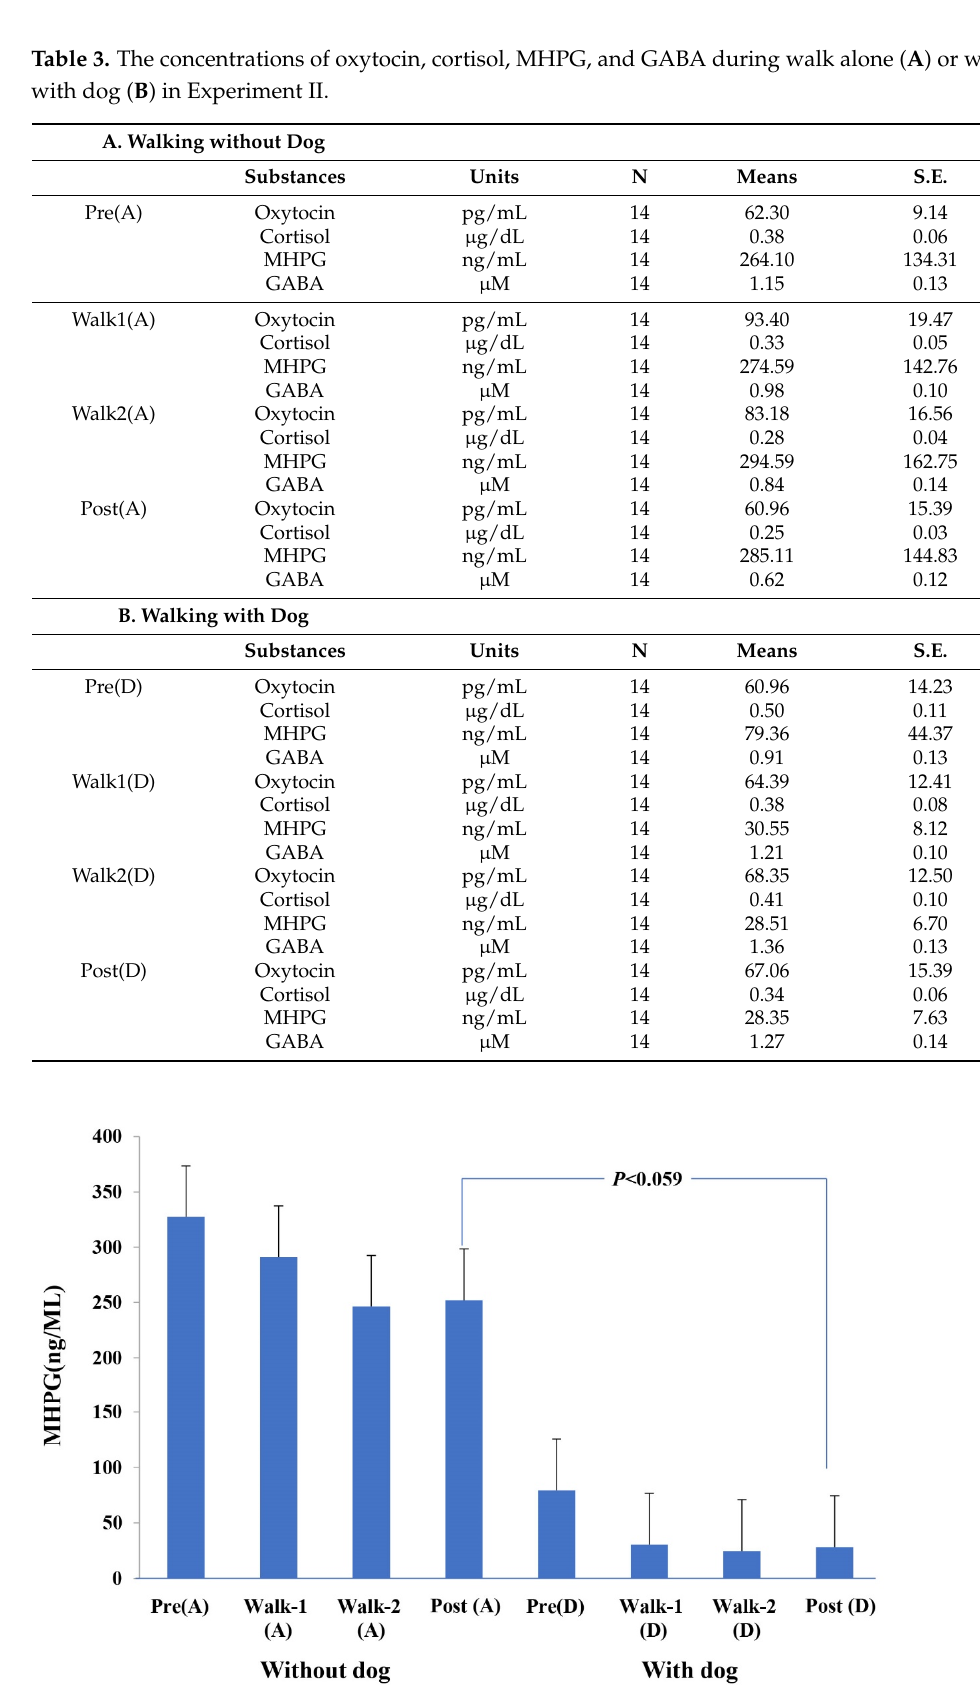
Figure 2. MHPG levels in owners’ saliva, Experiment II.